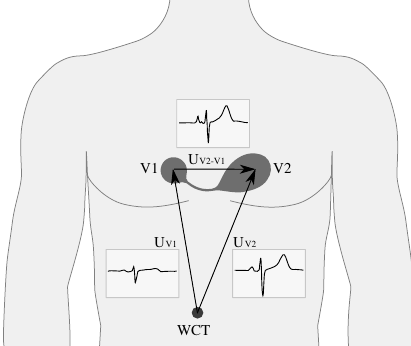
Figure 1. A differential lead from the positions of the V1 and V2 electrodes of a multi-channel ECG,